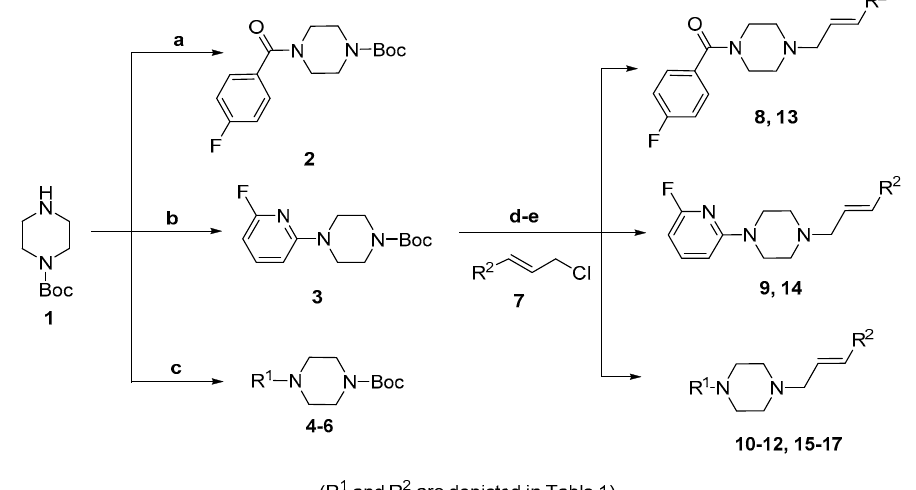
Figure 2. Design of fluorinated cinnamylpiperazines as potential MAO-B ligands. Fusion of the arylpiperazine (blue) and the cinnamyl pharmacophores (red) with different aryl fluorine-containing